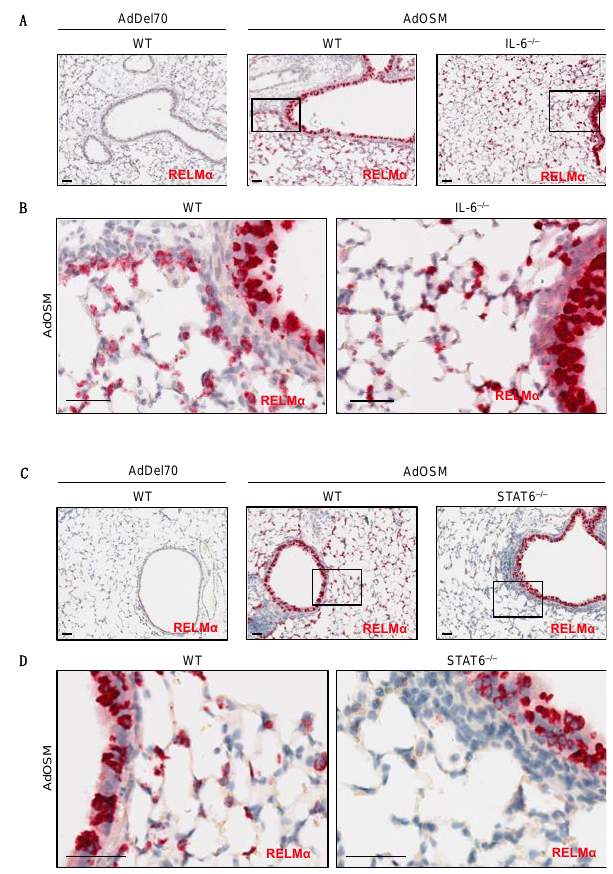
Figure 4. RELMα mRNA induction in situ by OSM in IL-6 –/– and STAT6 –/– mice. Representative images Figure 4. RELM α mRNA induction in situ by OSM in IL-6 – / – and STAT6 – / – mice. Representative are shown of CISH staining for RELMα (red) in formalin-fixed paraffin-embedded lung tissue images are shown of CISH staining for RELM α (red) in formalin-fixed para ffi n-embedded lung sections from C57Bl/6 mice 7 days after treatment ( n = 4–8 mice/group). ( A ) RELMα mRNA (red) in tissue sections from C57Bl / 6 mice 7 days after treatment ( n = 4–8 mice / group). ( A ) RELM α mRNA (red) in AdDel70-treated wild-type, AdOSM-treated wild-type or IL-6 – / – mouse lung sections as indicated. ( B ) High magnifications images of boxed regions in A from AdOSM-treated mouse lungs of wild-type (left panel) or IL-6 – / – (right panel). ( C ) RELM α mRNA (red) in AdDel70-treated wild-type, AdOSM-treated wild-type and STAT6 – / – mouse lung sections as indicated. ( D ) Higher magnification images of indicated (boxed) regions from AdOSM-treated mouse lungs in ( C ). Scale bars, 50 µ